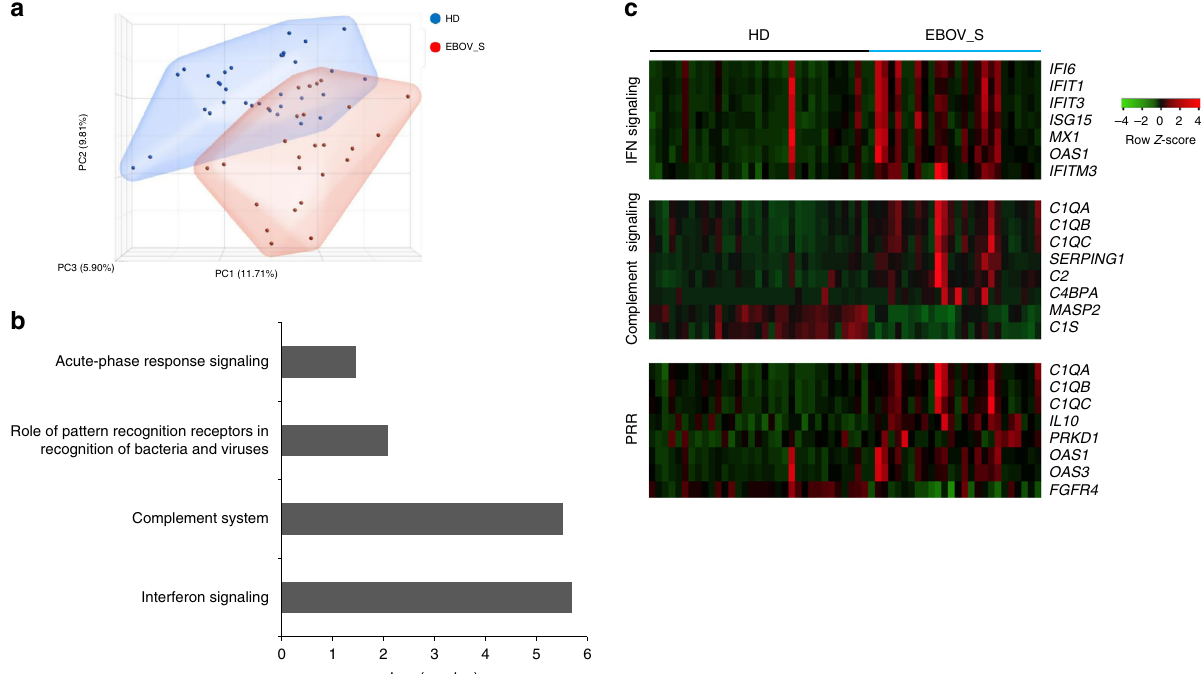
Fig. 4 Enrichment of genes associated with in fl ammation and antiviral response in EBOV_S. Unsupervised principal component analysis (PCA) of EBOV_S ( n = 26) and HDs ( n = 33). EBOV_S are indicated in red and HDs in blue ( a ). Ingenuity Pathway software analysis of the genes involved in immune responses differentially expressed in EBOV_S and HDs ( b ). Heatmap of genes from the main pathways associated with differentially expressed genes in EBOV_S and HDs, including IFN signaling, the complement system and PRR signaling pathways. Each column depicts one subject (HD or EBOV_S) ( c